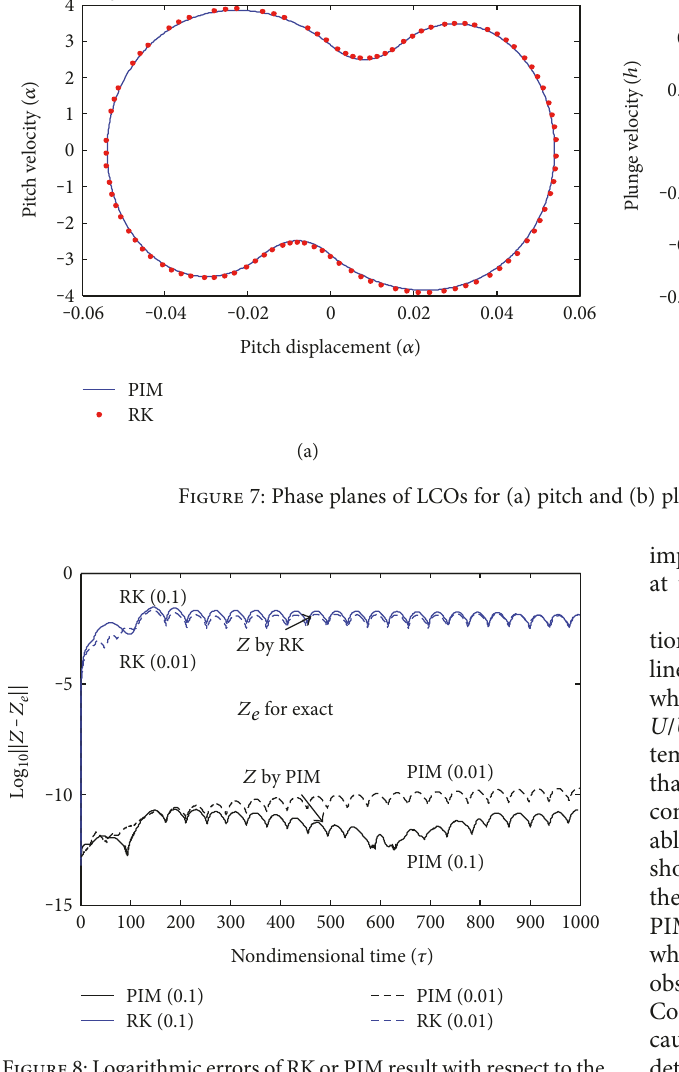
=0.87 in pitch 0